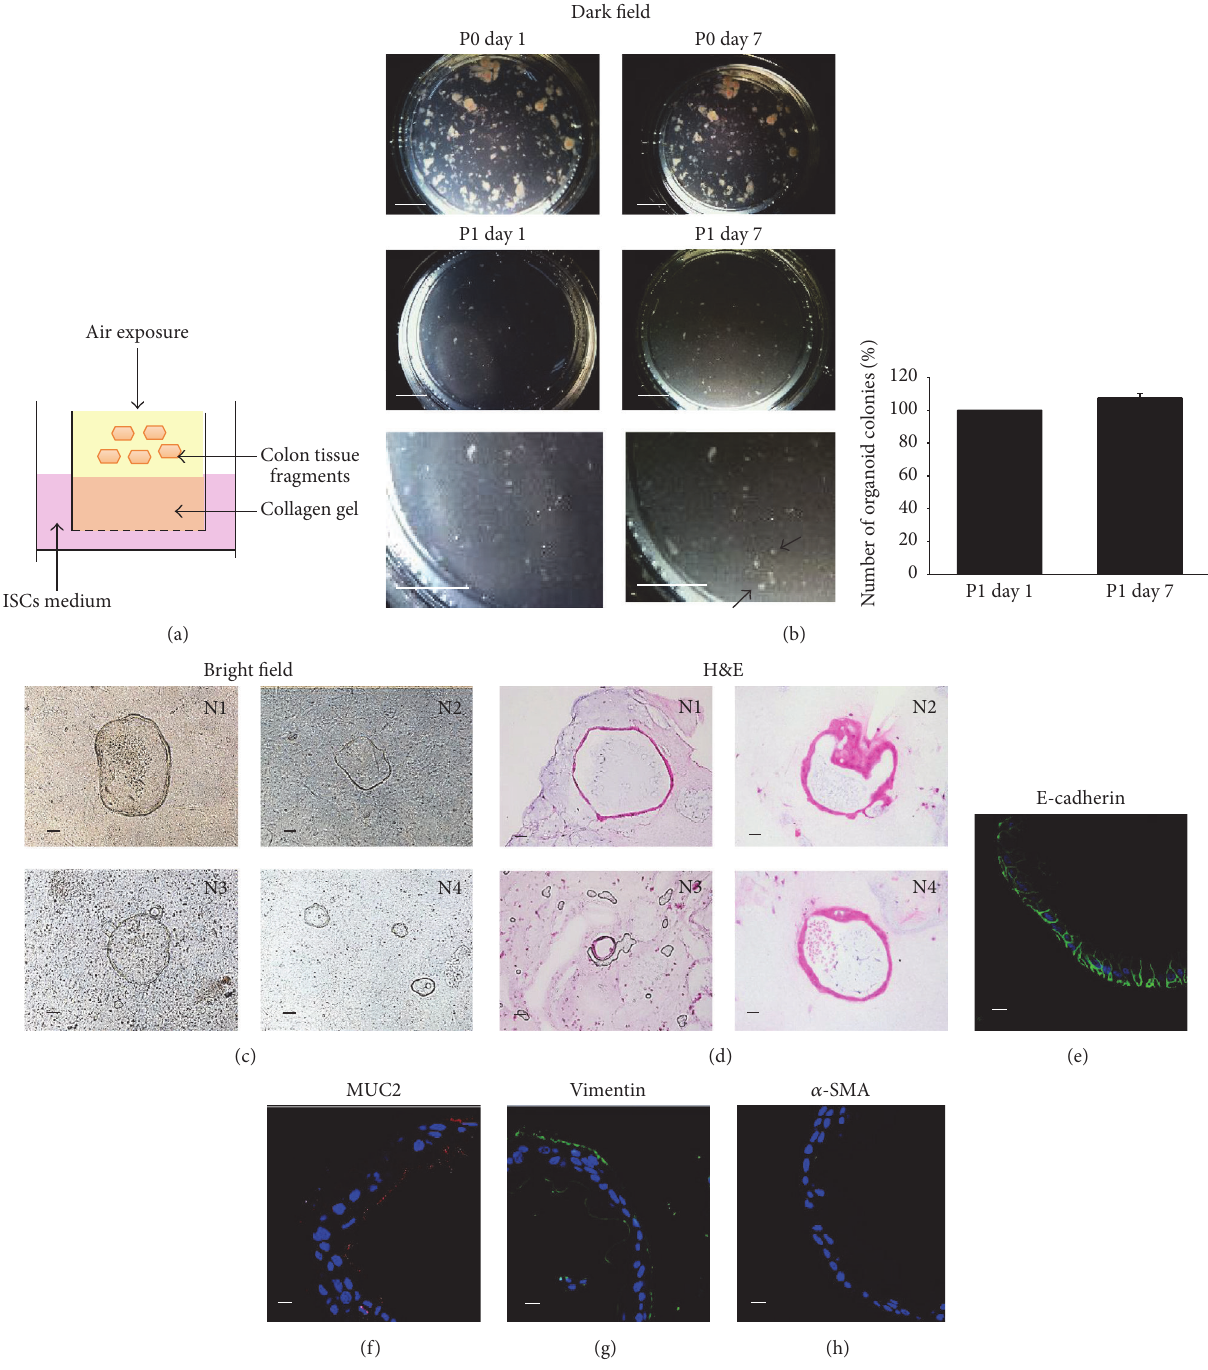
Figure 1: Generation of human air liquid interface (ALI) normal colorectal organoids. Schematic experimental design of a three-dimensional (3D) culture system. Human normal colon tissue fragments were seeded in collagen gels under an ALI microenvironment and cultured in intestinal stem cells (ISCs) media (a). Pictures were taken at days 1 and 7 after seeding tissues and at days 1 and 7 after passage (b). Scale bar: 5mm. Enlarged pictures of postpassage are shown under the original pictures at passage 1. Arrows show the grown-up organoids. The number of organoid colonies was counted ( n = 4). Representative images for phase contrast microscope (c) and hematoxylin and eosin (H&E) staining (d) of human ALI normal colorectal organoids from four patients (N1, N2, N3, and N4) are shown. Culture day 30. Scale bar: 200 𝜇 m (c) and 100 𝜇 m (d). Expression of an epithelial cell marker, E-cadherin (e), a goblet cell marker, MUC2 (f), a fibroblast marker, vimentin (g), and a myofibroblast marker, 𝛼 -smooth muscle actin (SMA) (h). Representative photomicrographs were shown ( n = 4). Culture day 30. Scale bar: 50 𝜇 m